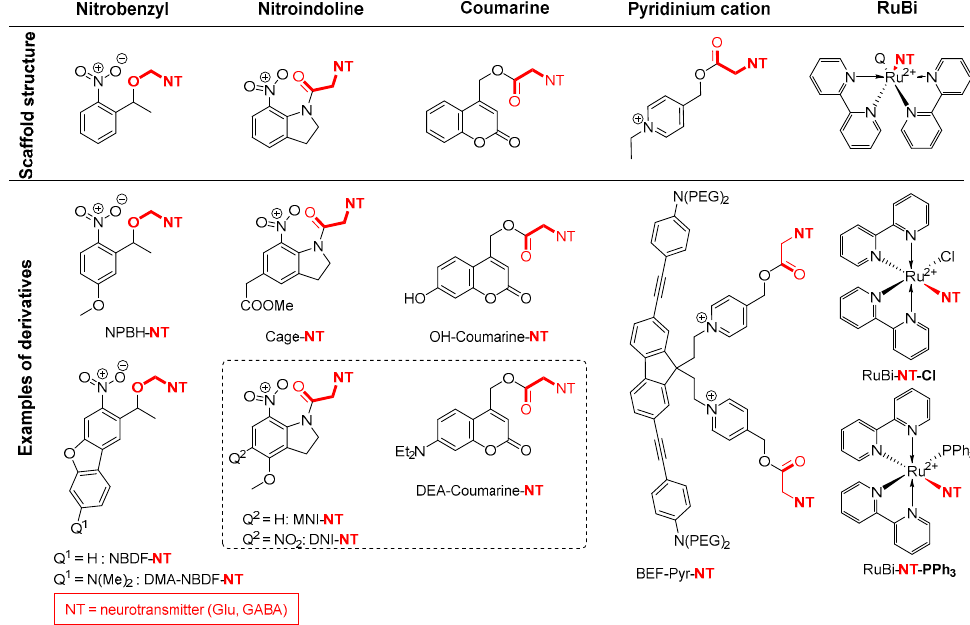
Figure 22. Collection of the most prominent cage-scaffolds ( top ) and some derivatives ( bottom ). NT = neurotransmitter. Compounds in the box are the subject of discussion.